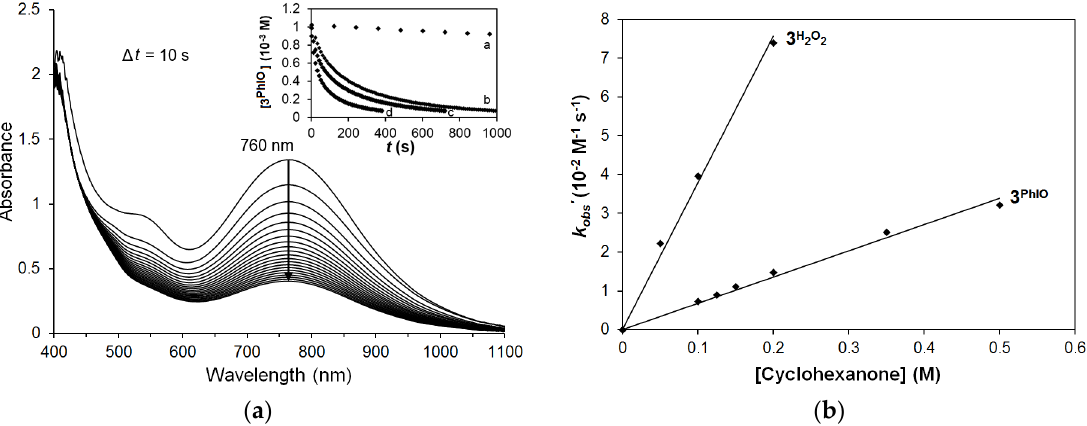
Figure 11. Stoichiometric 3 PhIO – mediated Baeyer–Villiger oxidation of cyclohexanone: ( a ) UV-Visible spectral change for 3 PhIO -mediated oxidation of cyclohexanone in MeCN at 15 °C ( Δ t = 10 s). Inset: The change of 3 PhIO concentration derived from the reaction of 3 PhIO and cyclohexanone: [ 3 ] = 10 − 3 M, without substrate (a), [substrate] = 0.1 M ( b ) [substrate] = 0.15 M (c), [substrate] = 0.2 M (d); ( b ) Substrate dependence. [ 3 ] = 10 − 3 M, T = 15 ◦ C, iron(III) intermediates ( 3 PhIO and 3 H 2 O 2 ) were generated with PhIO and H 2 O 2 , respectively, the k obs ’ data were taken from the Table